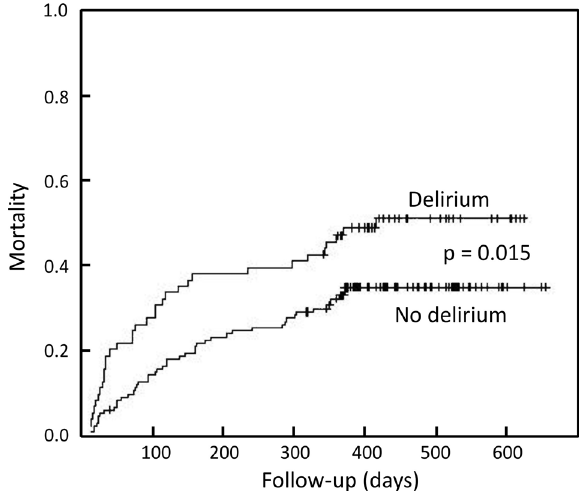
Figure 1. Delirium in hospitalized elderly patients predicts post-discharge mortality (See Lima et al. in this issue of